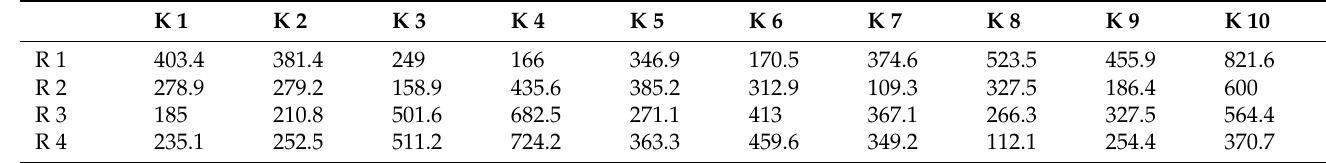
Table A4. Distance between recycling center R and sales/collection center K (km).